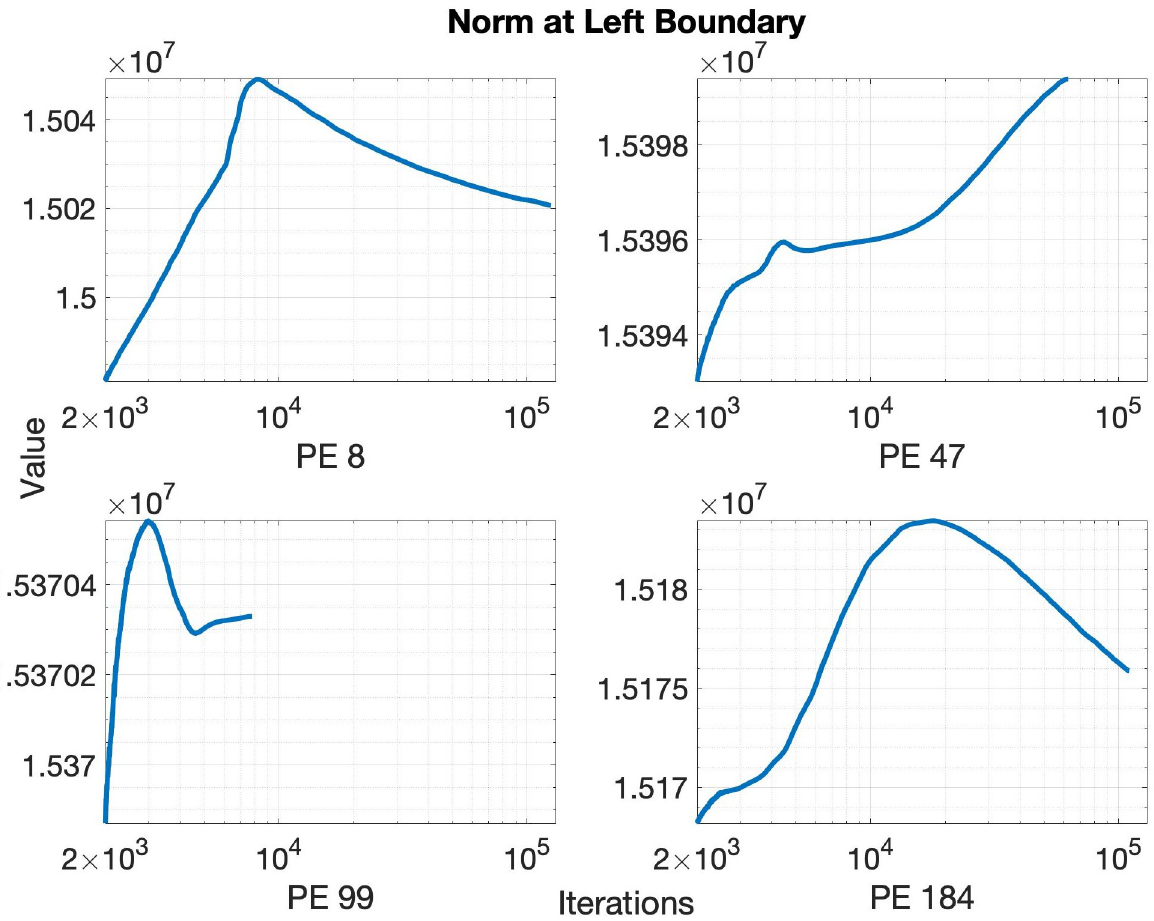
Fig 5. Evolution of the Manhattan or L-1 norm of the top boundary of 4 randomly chosen PEs. Note that the x axis starts from 2000 to wait for the large scale oscillations to die out.